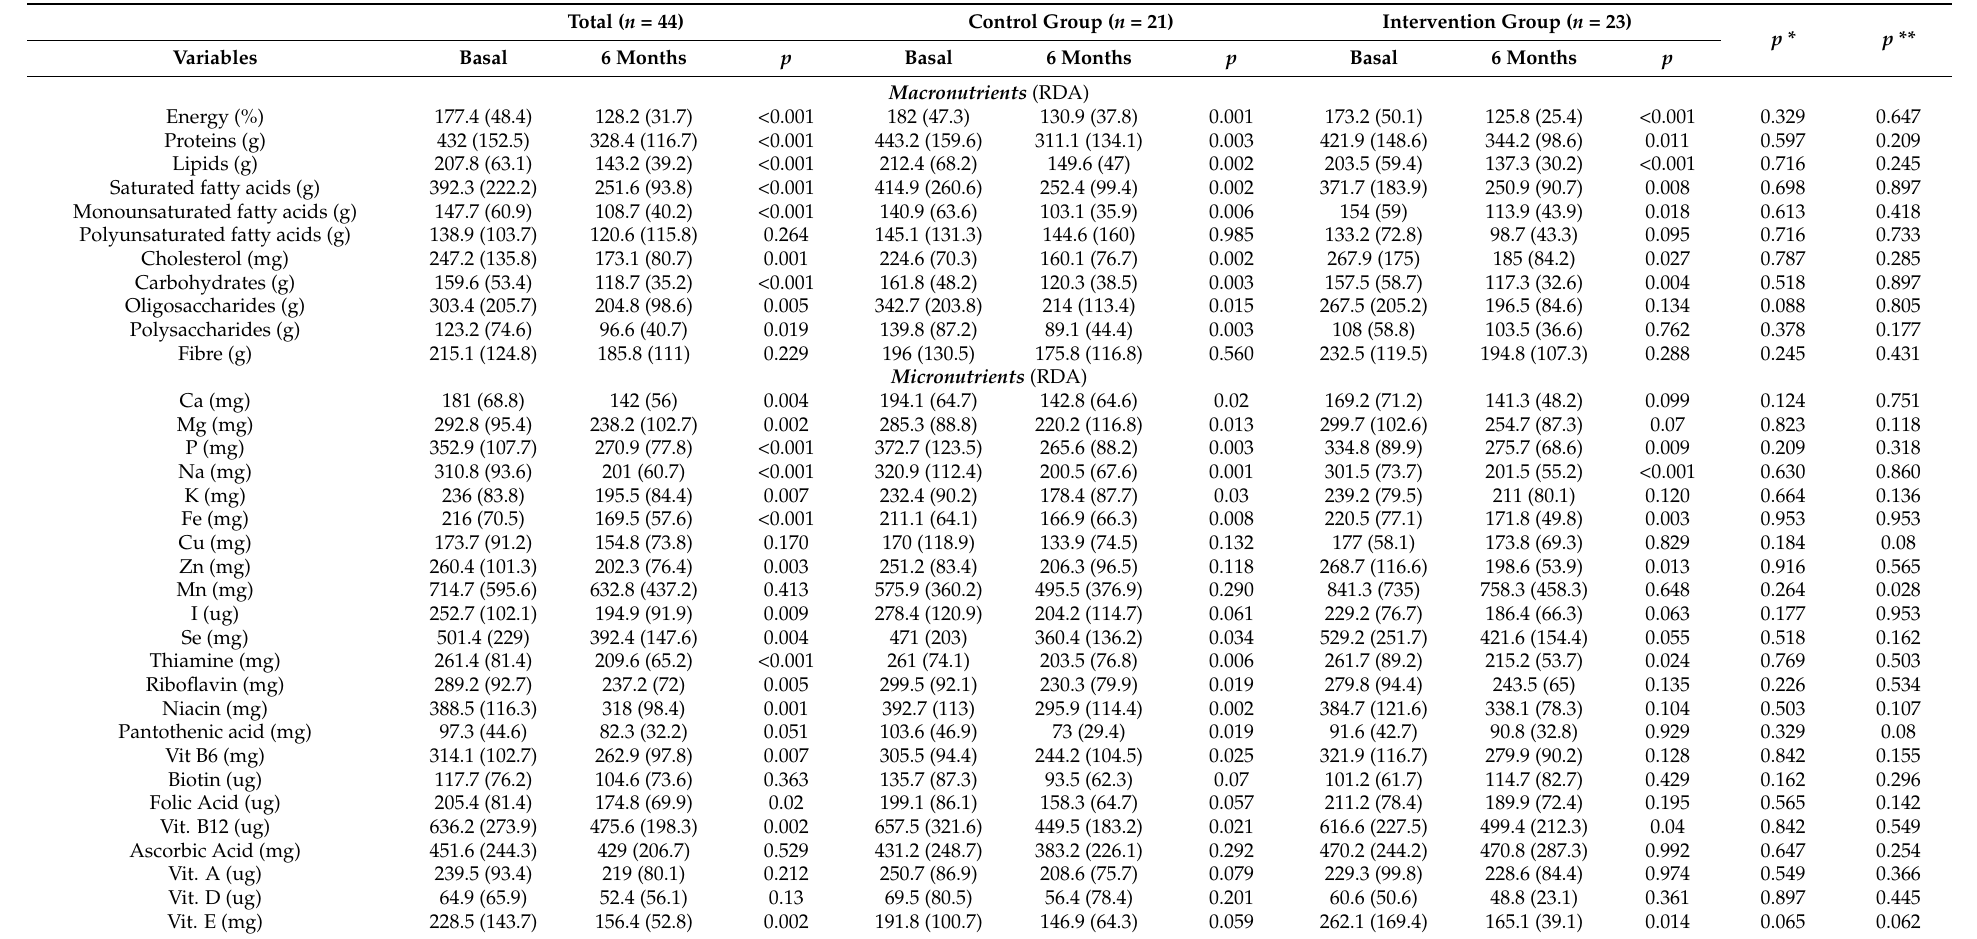
Table 3. Modifications in allocation groups: control group and experimental